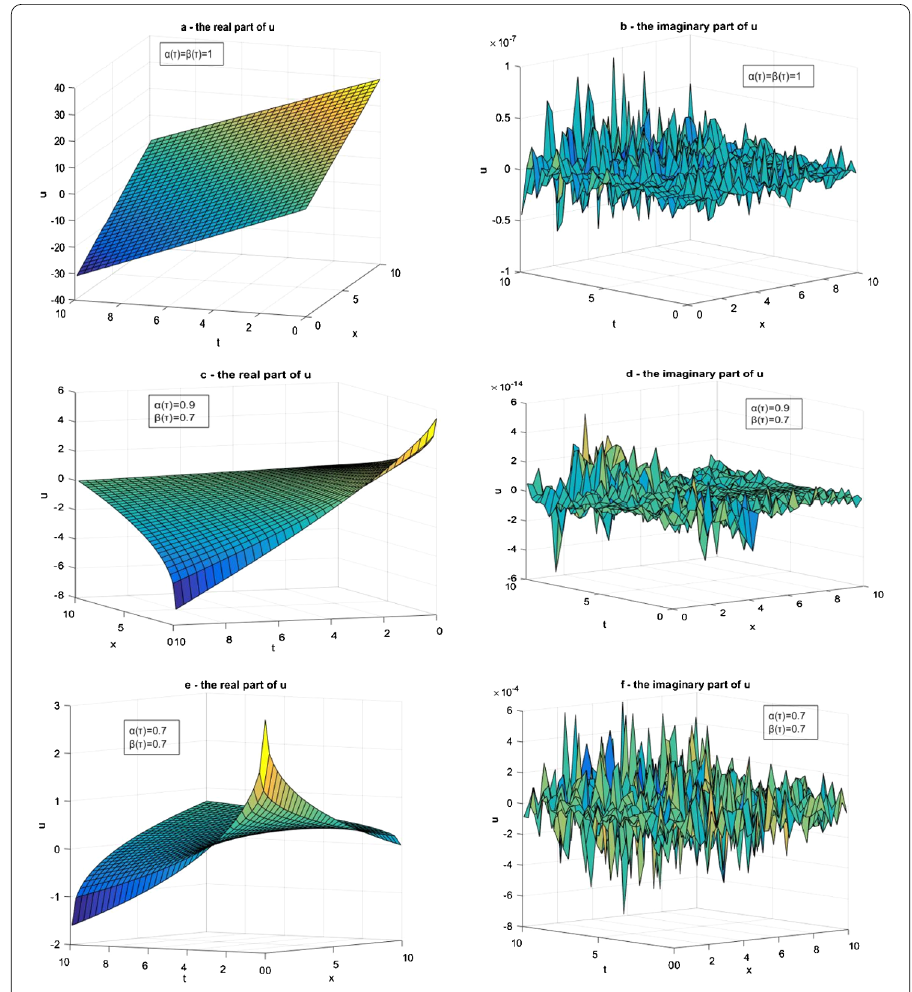
Figure 8 ( a ), ( c ), ( e ) and ( b ), ( d ), ( f ) are respectively the graphs of the real and the imaginary parts of the solution u in Example 5 for different values of α ( τ ) and β ( τ